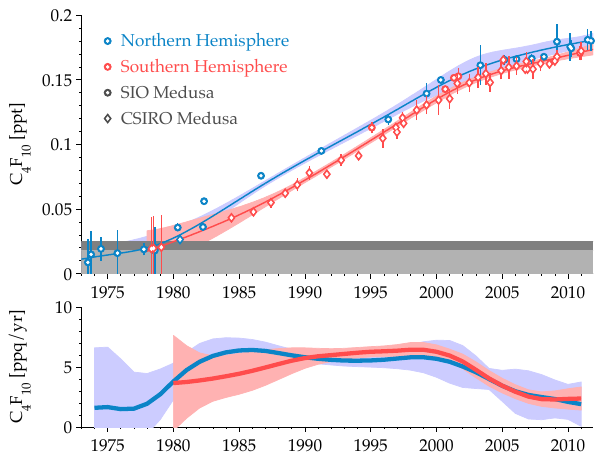
Fig. 3. Same as Fig. 1, but for C 6 F 14